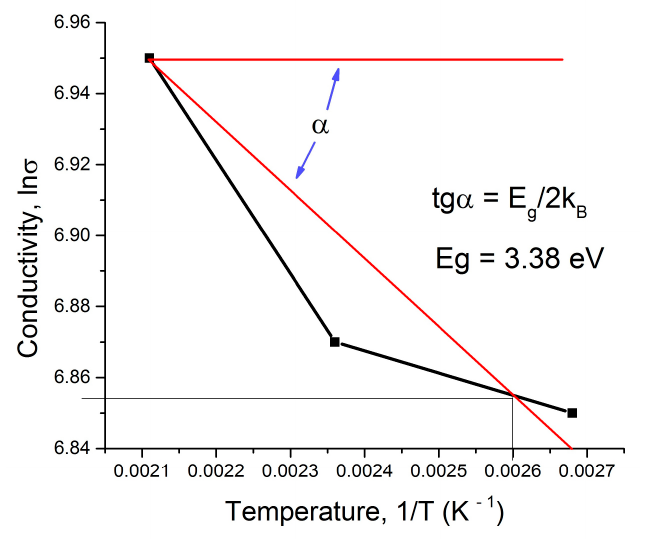
Figure 11. Evaluation of the semiconductor bandgap by experimentally obtained conductivity. Table 6. Measured voltage and basic calculated parameters of the low-resistance AZO film.